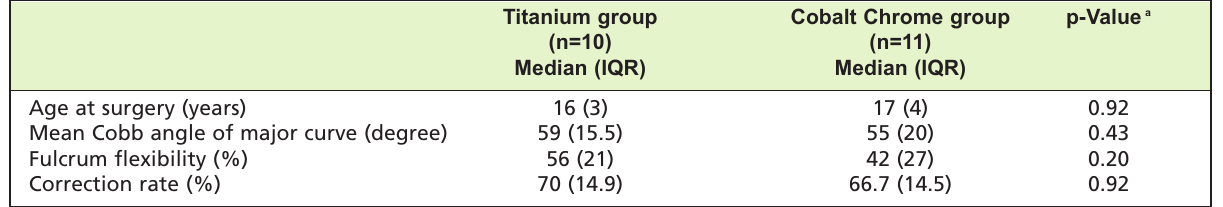
Radiological characteristics of titanium and cobalt chrome groups Table I: